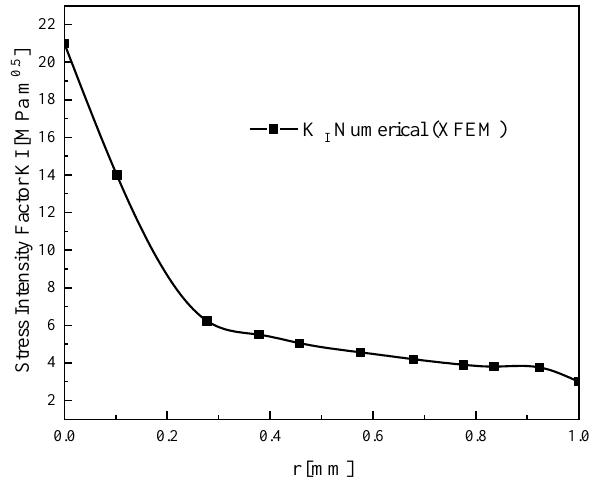
Figure 4. Distribution stress intensity factor SIF at the notch tip–SIF and r for a/t = 0.2. The elastic SIF distribution at the notch tip decreases with distance from the tip of notch, for a/t = 0.2 the maximum value of SIF is 21 MPa√m at notch tip, i.e., 𝑟 = 0 (see Figure 4). Near the notch tip SIF decreases rapidly to 6 MPa√m at r = 0.3 mm, then its variation becomes slower.